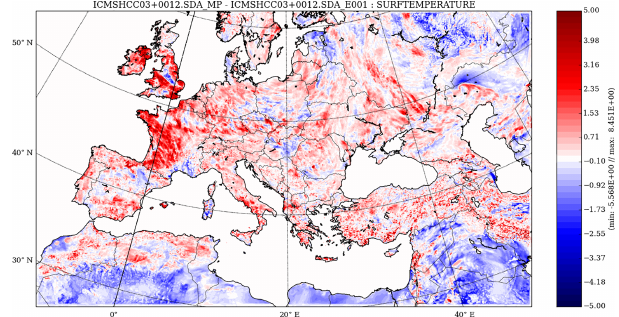
Figure 4. Surface temperature perturbation by multi-physics method (differences after 12h of integration).